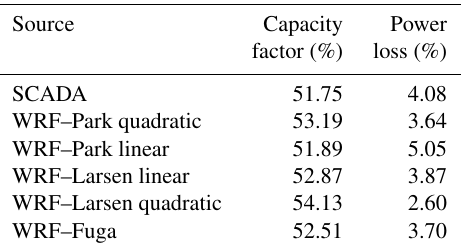
Figure 7. Normalized average power of the north–south row of turbines in the middle of the wind farm for southerly flow conditions from SCADA and simulations from the wake models within the range 168.7 ± 15 ◦ and hub-height inflow wind speed of 9 ± 0.5ms − 1 . For the SCADA, the shaded region indicates ± the standard error of the mean. Table 3. Observed and estimated (from the WRF-wake model setup) capacity factors of the Anholt wind farm for 2014. The esti- mated values account for the observed average availability of sam- ples. The last column shows the power loss based on the SCADA and the power loss estimations from wake models without WRF